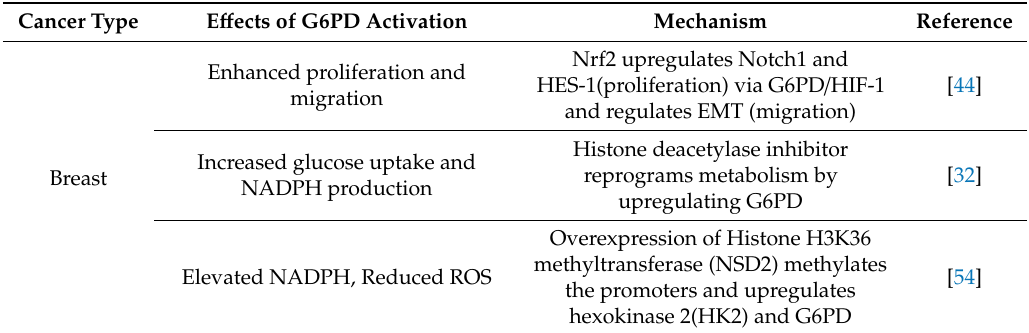
Table 1. The e ff ects of upregulated glucose-6-phosphate dehydrogenase (G6PD) in cells. Cancer